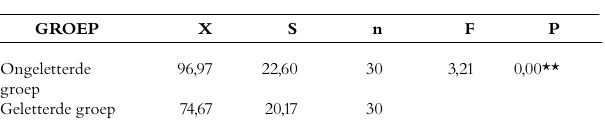
TABLE 2 STRESVLAK: GROEPE